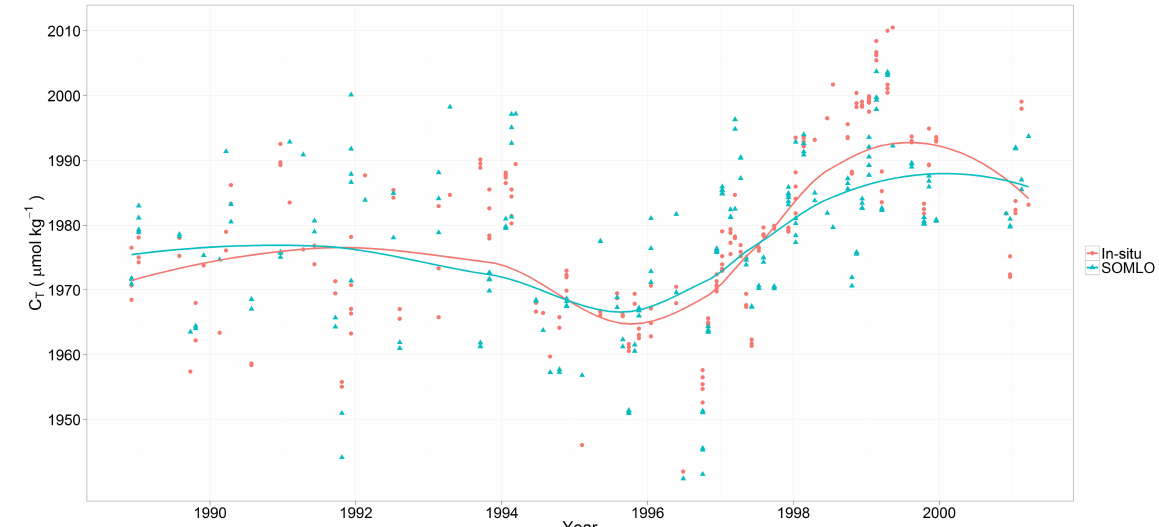
Fig. 18. In situ and independently predicted HOT C T measurements with loess